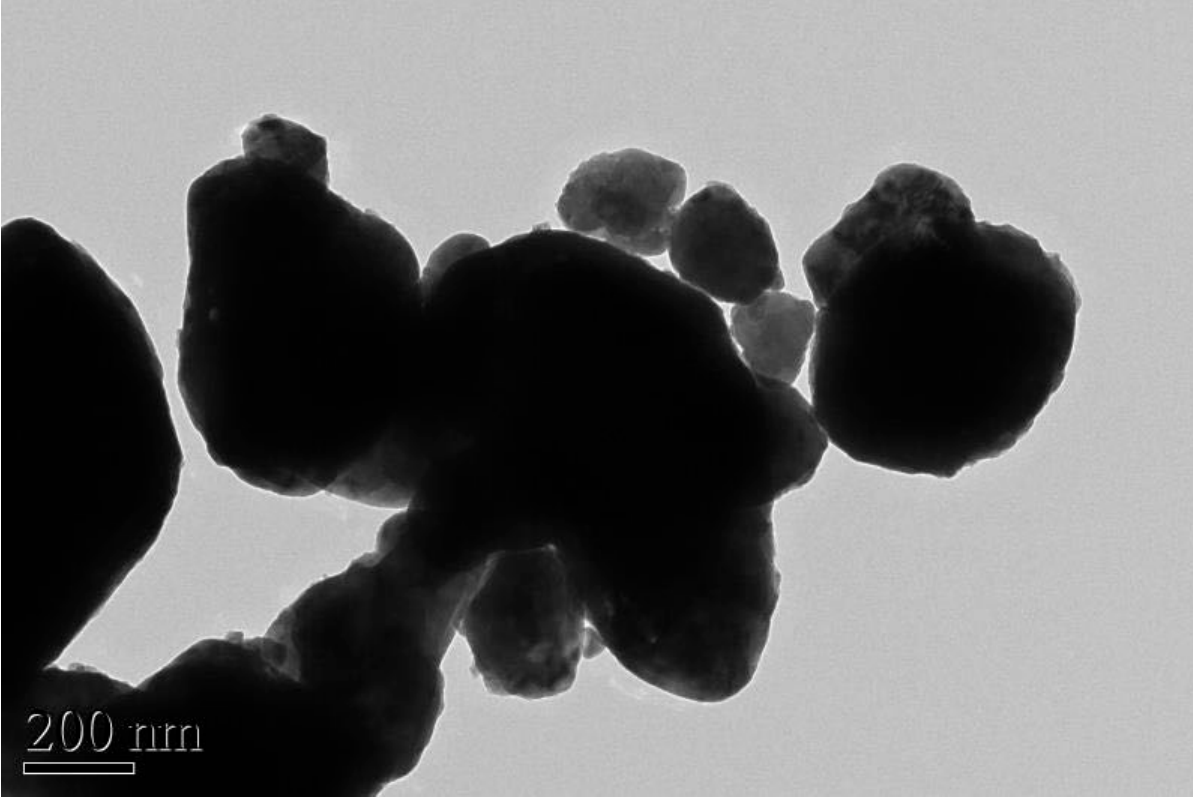
Figure 11. EDS elemental mapping of In 2 CdO 4 /Y 2 SmSbO 7 heterojunction (In, Cd, O from In 2 CdO 4 and Y, Sm, Sb, O from Y 2 SmSbO 7 ). Figure 12 shows the TG-DSC-DTA of Y 2 SmSbO 7 . It could be seen from Figure 12 that the thermal weight curve was obviously lost at 440 °C, and there was a signi fi cant promi- nent heat absorption peak, which meant that the high-purity In 2 O 3 and CdO powder ma- terials had an obvious absorption peak at 440 °C because it contained crystalline water. We also found from Figure 13 that there was a prominent endothermic peak at 700 °C, and thus the new phase Y 2 SmSbO 7 was formed at 700 °C. Similarly, it could be seen from Fig- ure 13 that a new phase of In 2 CdO 4 was formed at 720 °C.